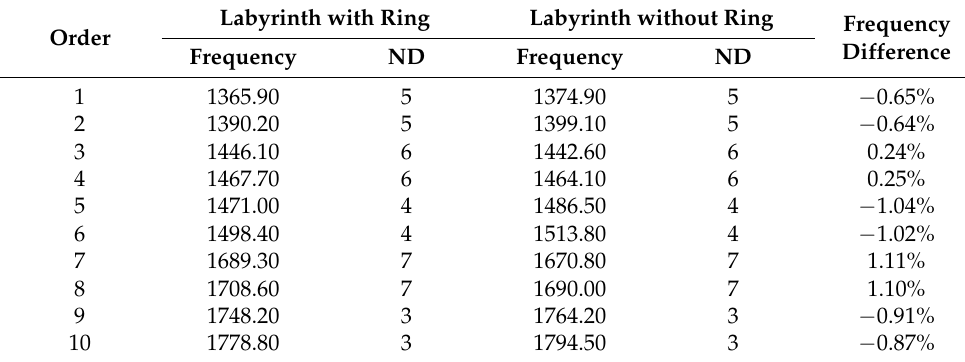
Table 5. Frequencies of two cases for the labyrinth seal-ring system. Labyrinth with Ring Labyrinth without Ring Frequency Order DifferenceFrequency ND Frequency ND